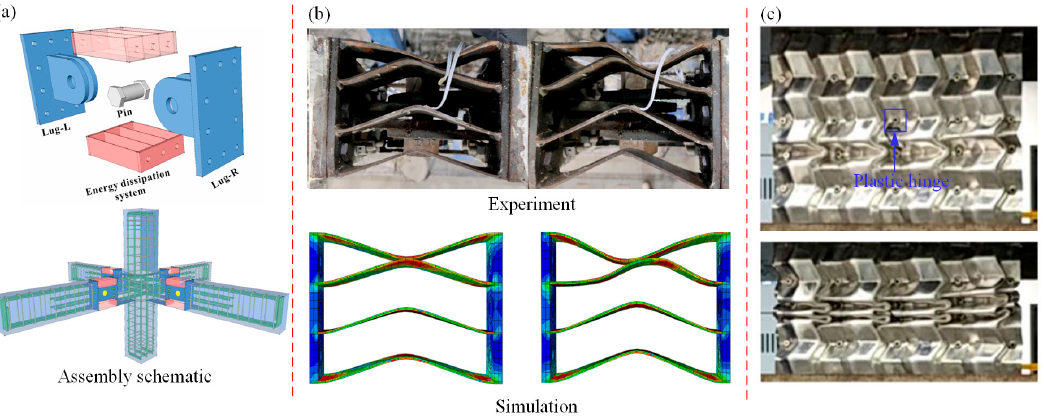
Figure 17. Application of plastic hinges in engineering: ( a ) schematic diagram of ACPH; ( b ) plastic hinge deformation of ACPH energy dissipation board [200,201]; ( c ) plastic hinge deformation of automobile energy-absorbing box [204].